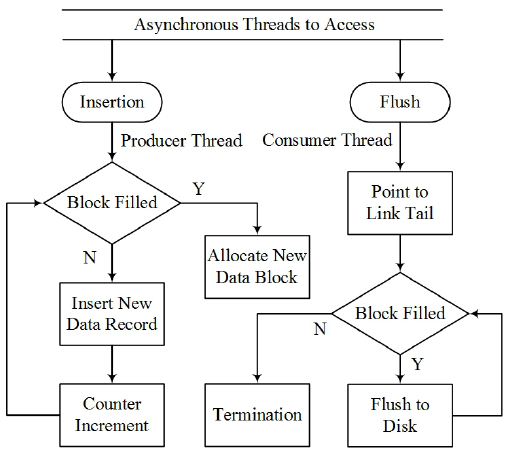
Figure 8. The lock-free data synchronization